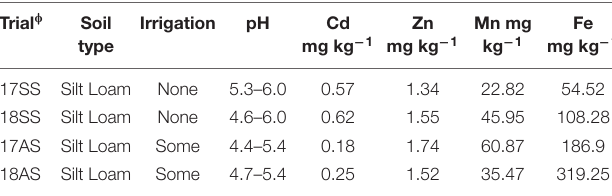
TABLE 1 | Content of four metals and pH in 0–30 cm soil in two irrigated and two non-irrigated field trials. Trial